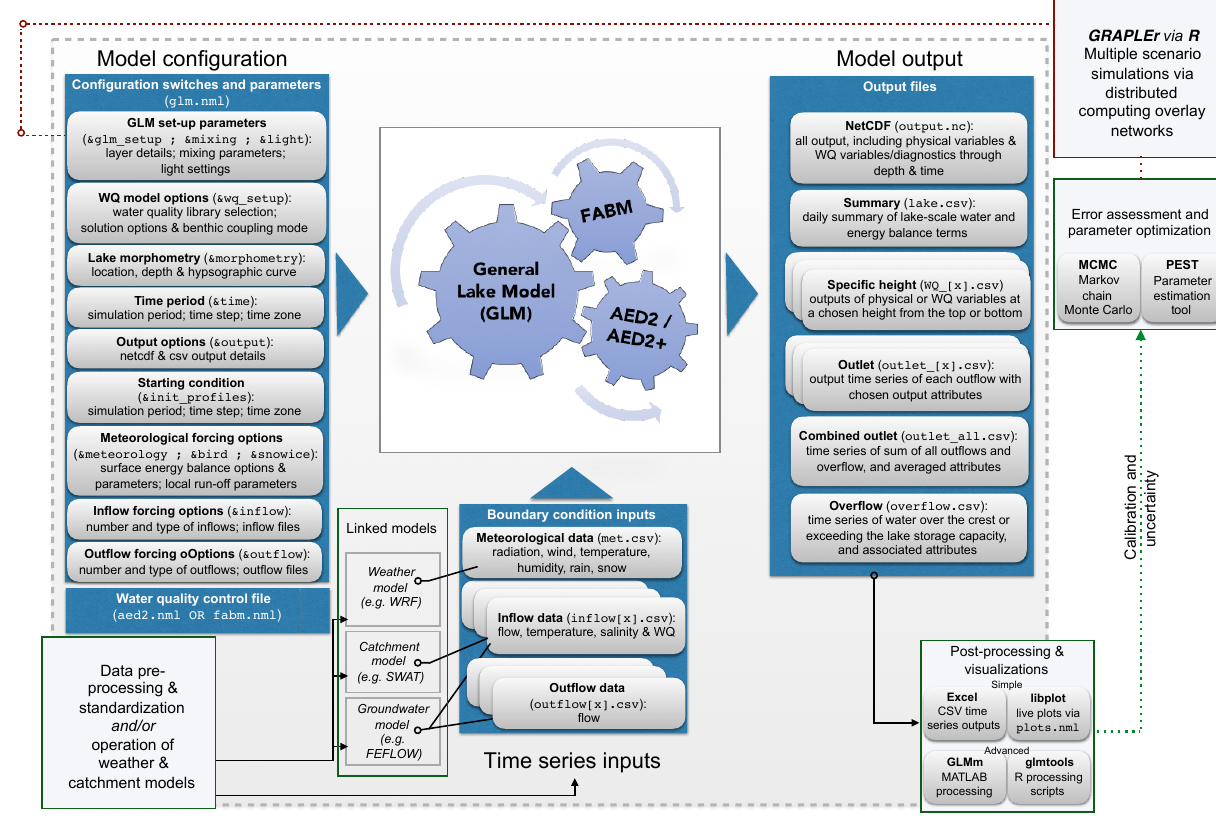
Figure 17. Flow diagram showing the input information required for operation of the model, the outputs, and analysis